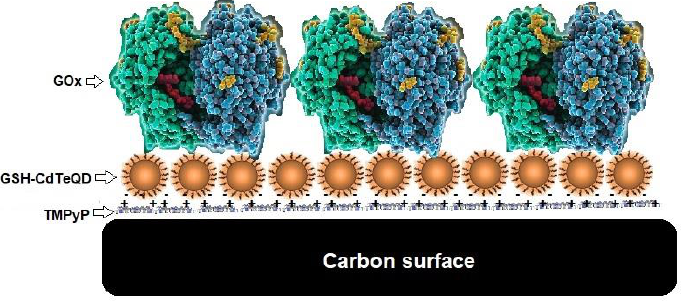
Figure 2. Scheme of TMPyP/GSH-CdTeQD/GOx system deposited on a carbon surface. The obtained results indicate that the TMPyP/GSH-CdTeQD/GOx system not only